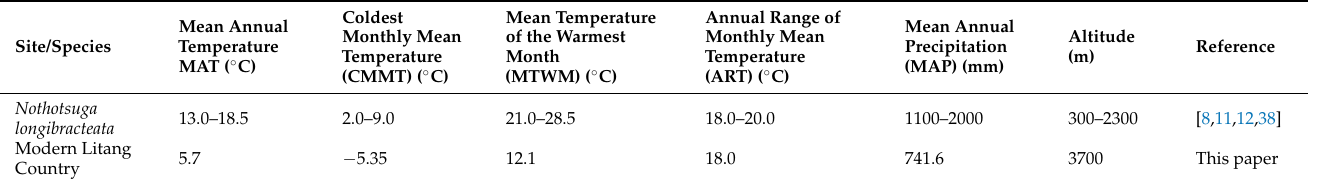
Table 1. The present climatic parameters of fossil localities and climate ranges of Nothotsuga longibracteata . Modern values are from the Litang meteorological